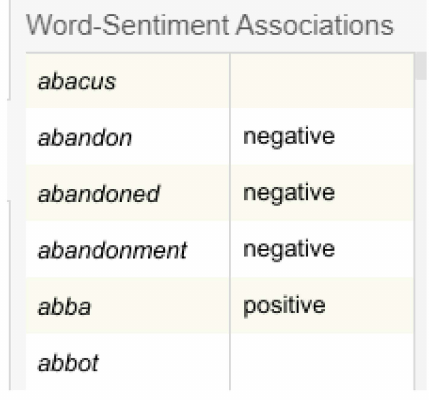
Figure 12. Visualization of NRC